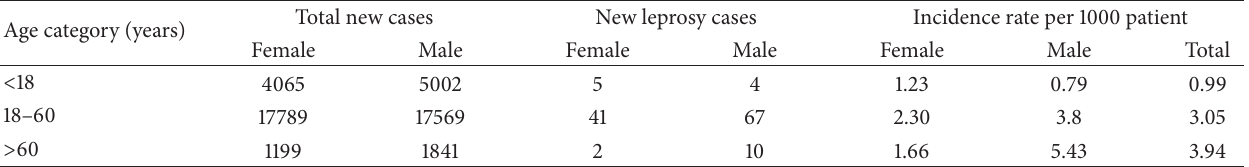
Table 2: Observed incidence rates of leprosy per 1000 patient by sex and age in a tertiary care hospital in Srinagar, Garhwal, North India (2009–2014).